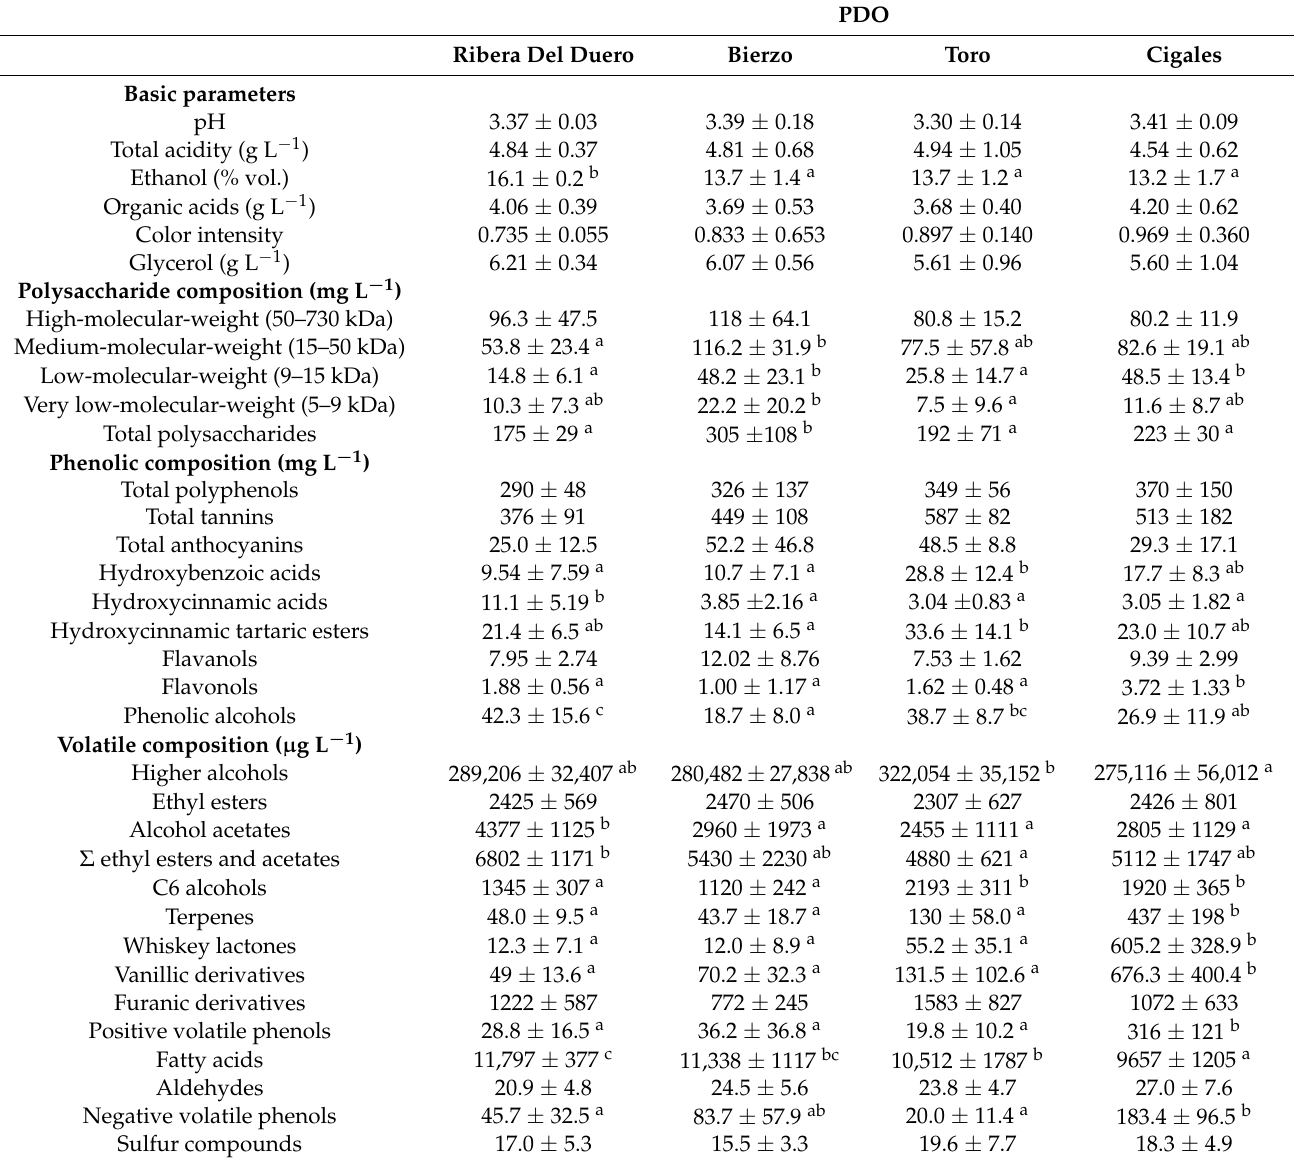
Table 3. Classic enological parameters, color intensity, organic acids, glycerol, phenolic and volatile content of ros é wines from different